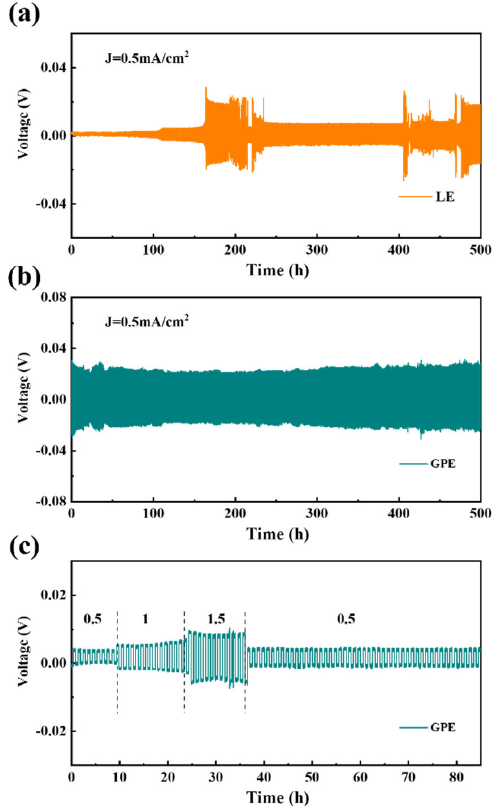
Figure 8. Galvanostatic tests of ( a ) Zn/LE/Zn and ( b ) Zn/GPE/ Zn at 0.5 mA ∙ cm − 2 , ( c ) voltage pro ‐ file of a Zn/GPE /Zn cell under various current